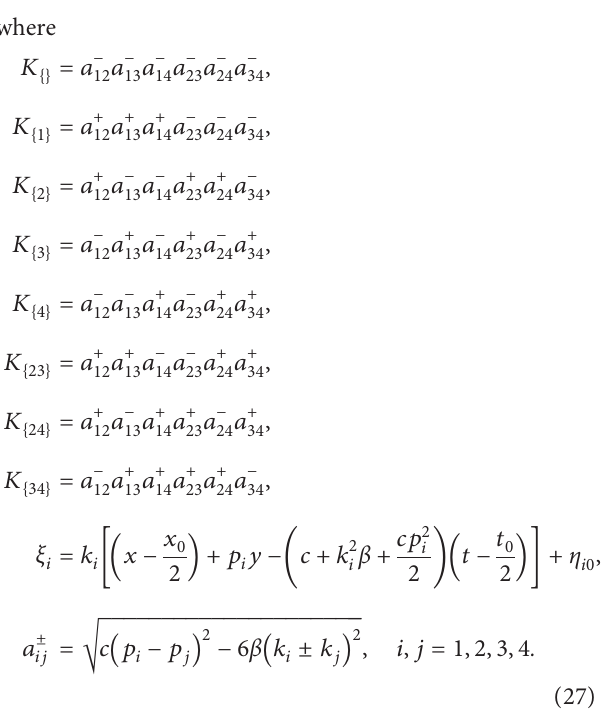
Figure 1: The symmetry breaking two-soliton solution (24) of the AB-KP systems (7a) and (7b), with the selecting parameters b � b � 0 and (b) and (c) b (a) b 1 2